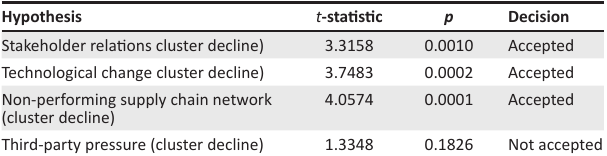
TABLE 4: Results of Hypothesis